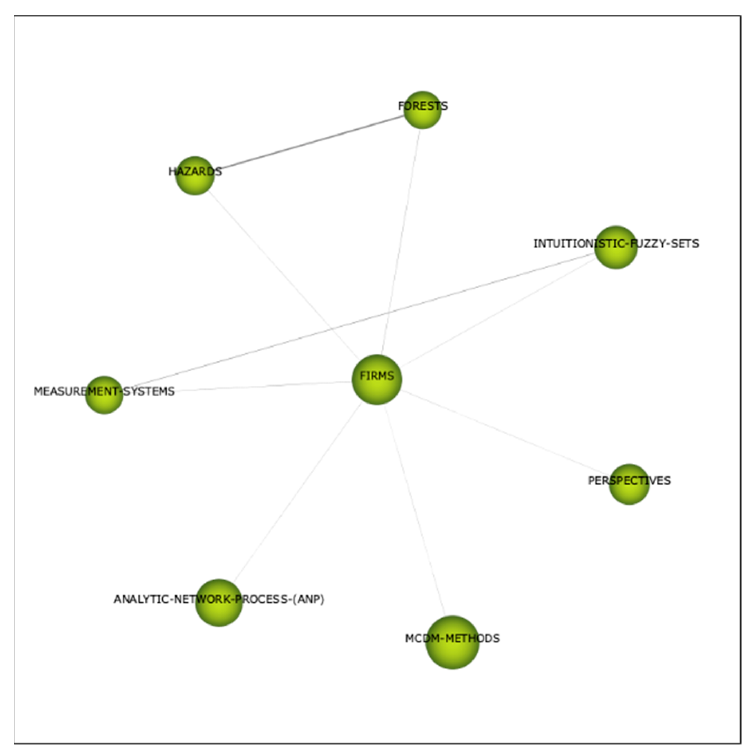
Figure A8. Firm cluster network.